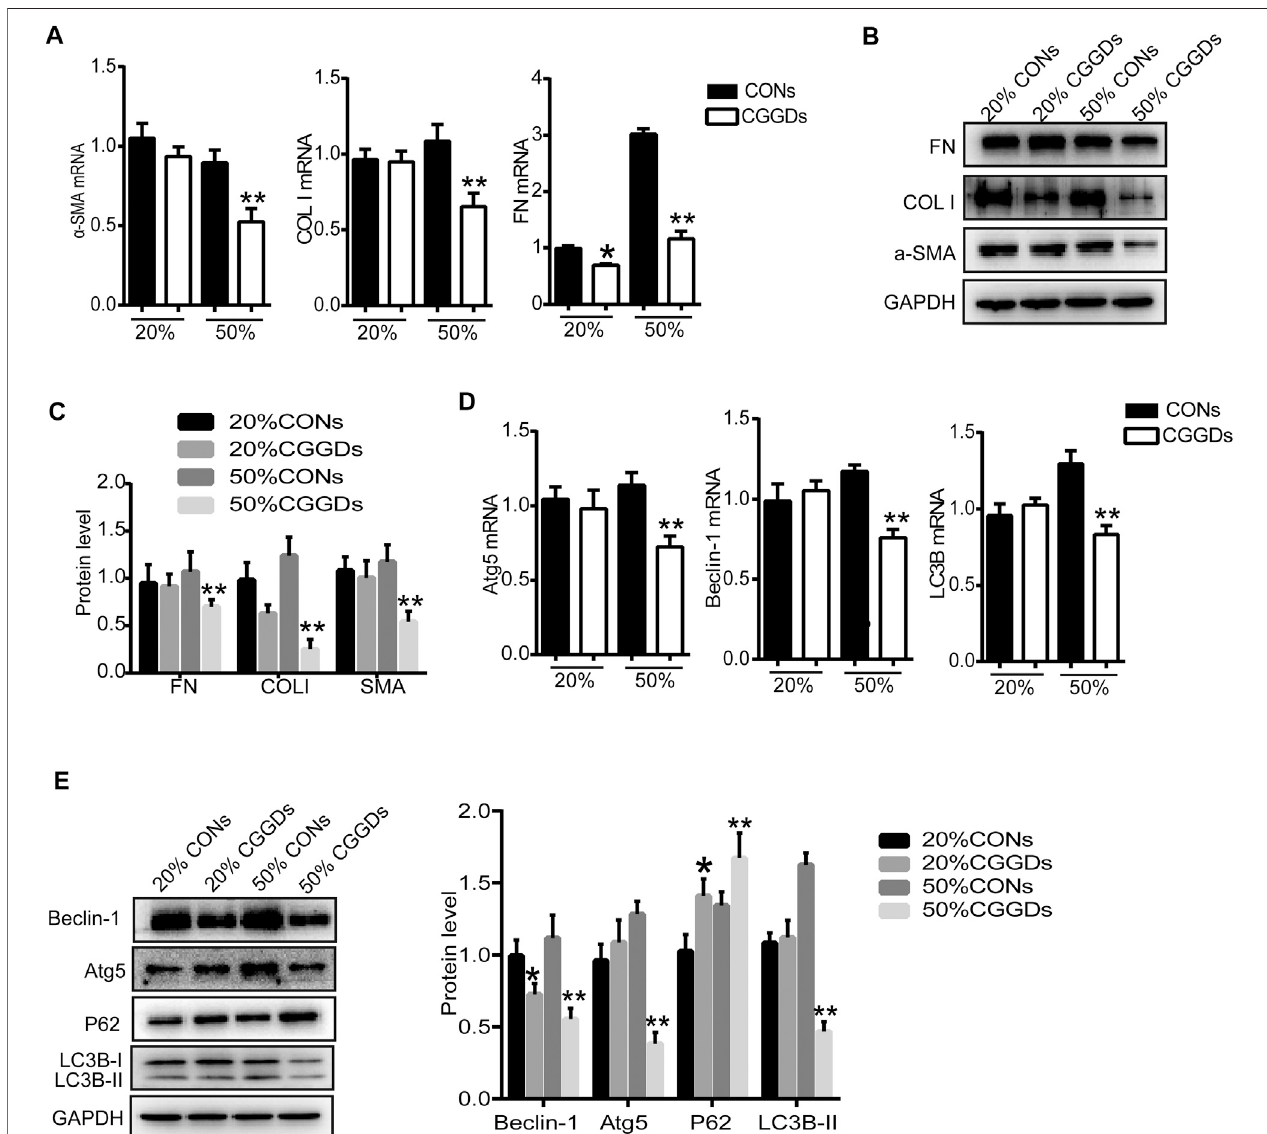
FIGURE 5 | CGGD-containing serum (CGGDs) inhibited PSC activation and autophagy. PSCs were treated with 20% or 50% control serum (CONs) or CGGDs, respectively, for 24 h. (A) RT-PCR analysis of α -SMA, COL I, and FN. (B) Western blot analysis of α -SMA, COL I, and FN. (C) Densitometry analysis of the western blot bandsof(B). (D) mRNAlevelsofAtg5,Beclin-1,andLC3Bdetected byRT-PCR. (E) WesternblotanalysisofBeclin-1, Atg5,P62,andLC3B.Thedataareexpressedas fold changes over the value of the 20% CONs group. The data are expressed as the mean ± SD of three independent experiments. * p < 0.05 vs. the 20% CONs group; ** p < 0.05 vs. the 50% CONs